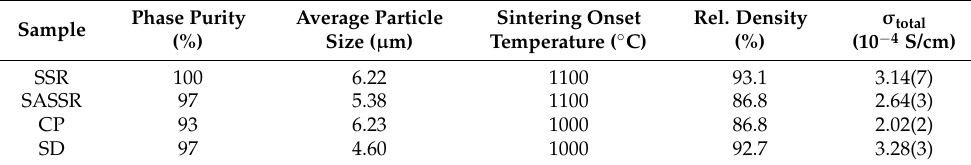
Table 5. Summary of the main material parameters as described in